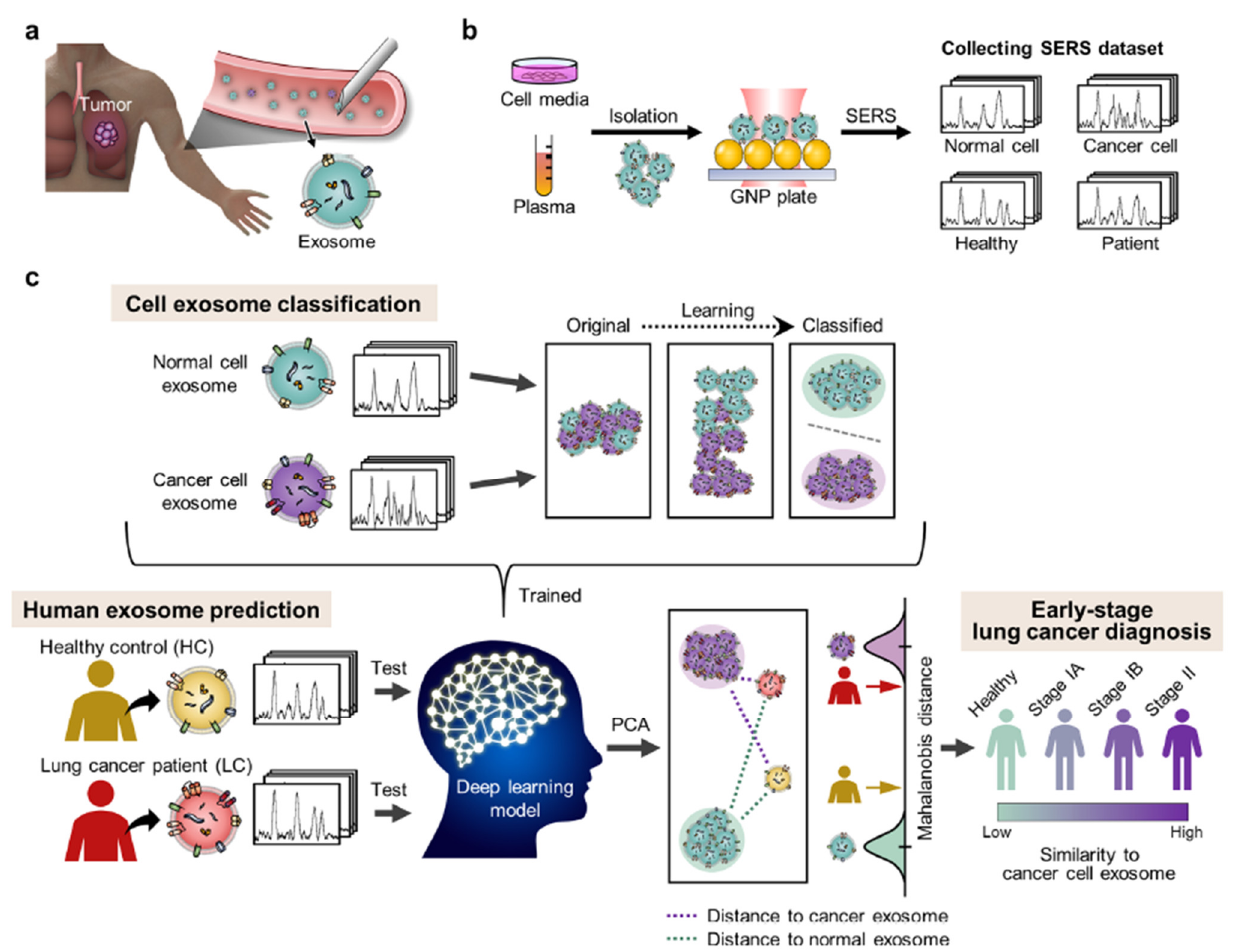
Figure 3. Schematic of work created by Hyunku et al. in lung cancer identification via a combination of SERS and deep learning. ( a ) Exosomes that were used as biomarkers for sensing. ( b ) Sample preparation and data collection. ( c ) Deep learning model used for the classification of normal and cancer cells exosomes using SERS spectra. Reproduced with permission from [118]. Copyright (2020), American Chemical Society.